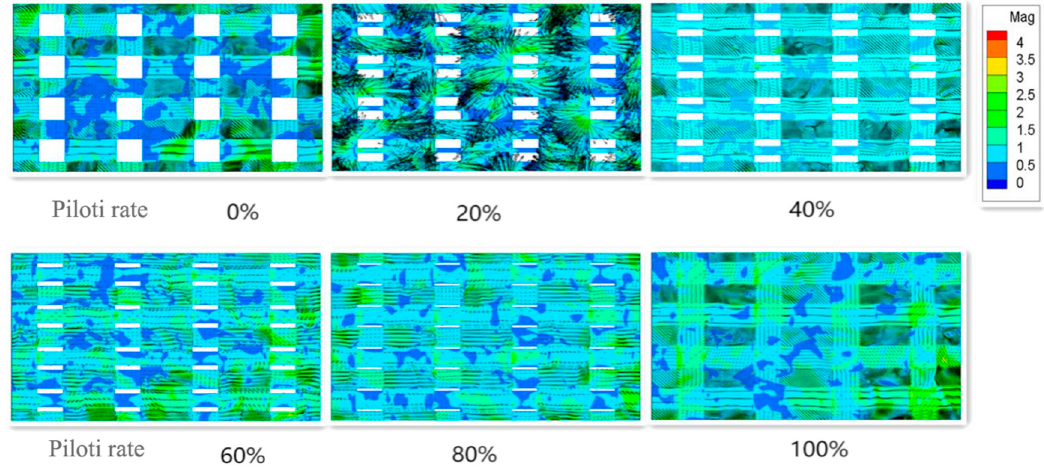
Figure 13. Vector diagram of the target area.